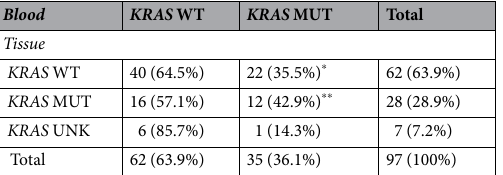
Table 1. Comparison of KRAS status (analysis restricted to codon G12D, G12V and G13D) between paired tissue (analysed by standard PCR-based techniques) and plasma samples (analysed by ddPCR). * In 11 cases the absence of tissue KRAS mutation was previously confirmed in both baseline biopsy and resection samples. ** In 3 cases the KRAS mutation which was found in ctDNA involved a different codon compared with the KRAS mutation which was previously detected in the tissue. Abbreviations: WT: wild-type; MUT: mutant; UNK: